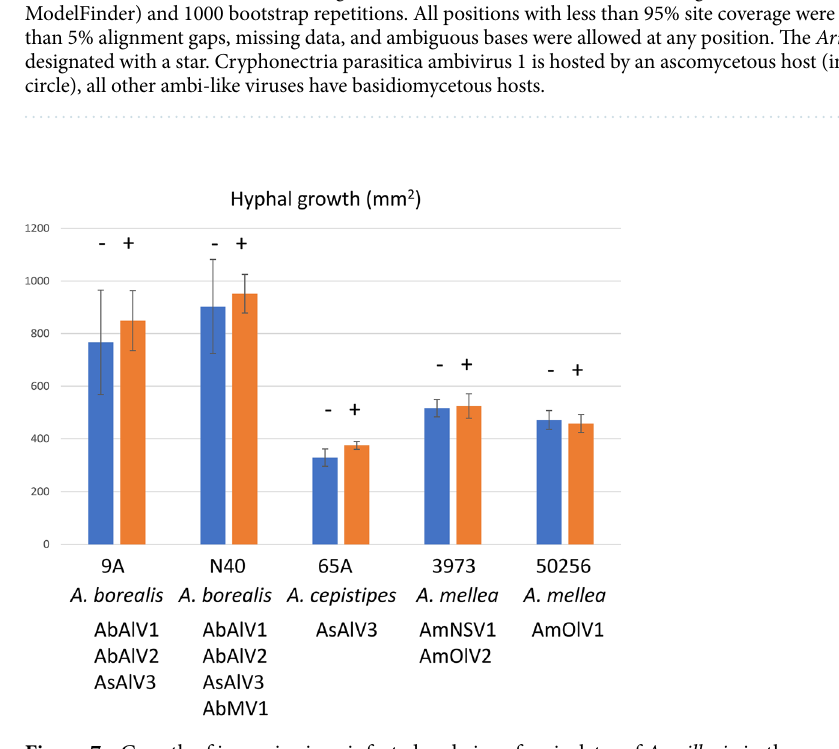
CMW50256, Al65A and Ab9A of viral infections. The highest incubation temperature used for the thermal treatment was 35 °C for isolates CMW50256 and Al65A and 36 °C for isolates N40, CMW3973 and Ab9A. The growth rate of the original and isogenic heat-treated virus-free Armillaria strains was compared by recording their growth on 2% malt extract agar (MEA) plates during a three-week period (Fig. 7). The presence of viruses did not appear to have a major effect on the growth rate of the Armillaria isolates in laboratory conditions.